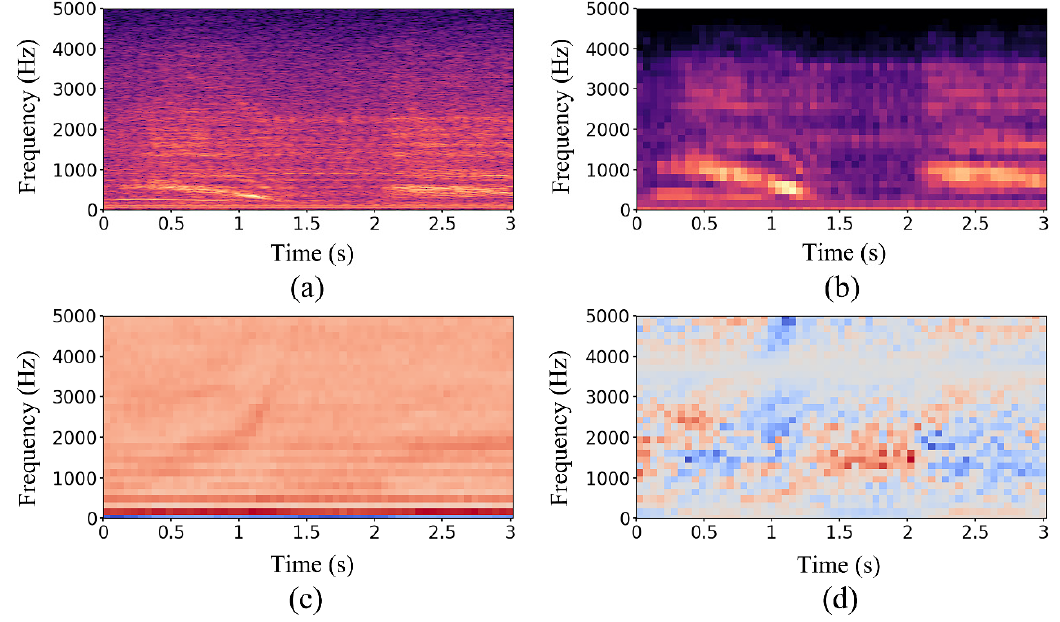
Figure 7. Frequency-domain features of the same audio sample. ( a ) Spectrogram (513 × 938), ( b ) Mel spectrogram (32 × 59), ( c ) MFCC (32 × 59), and ( d ) LFCC (32 × 59).